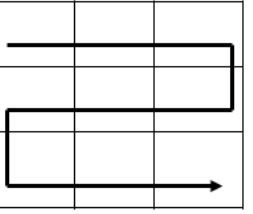
Figure 5. Example of inverse “S” scan path.